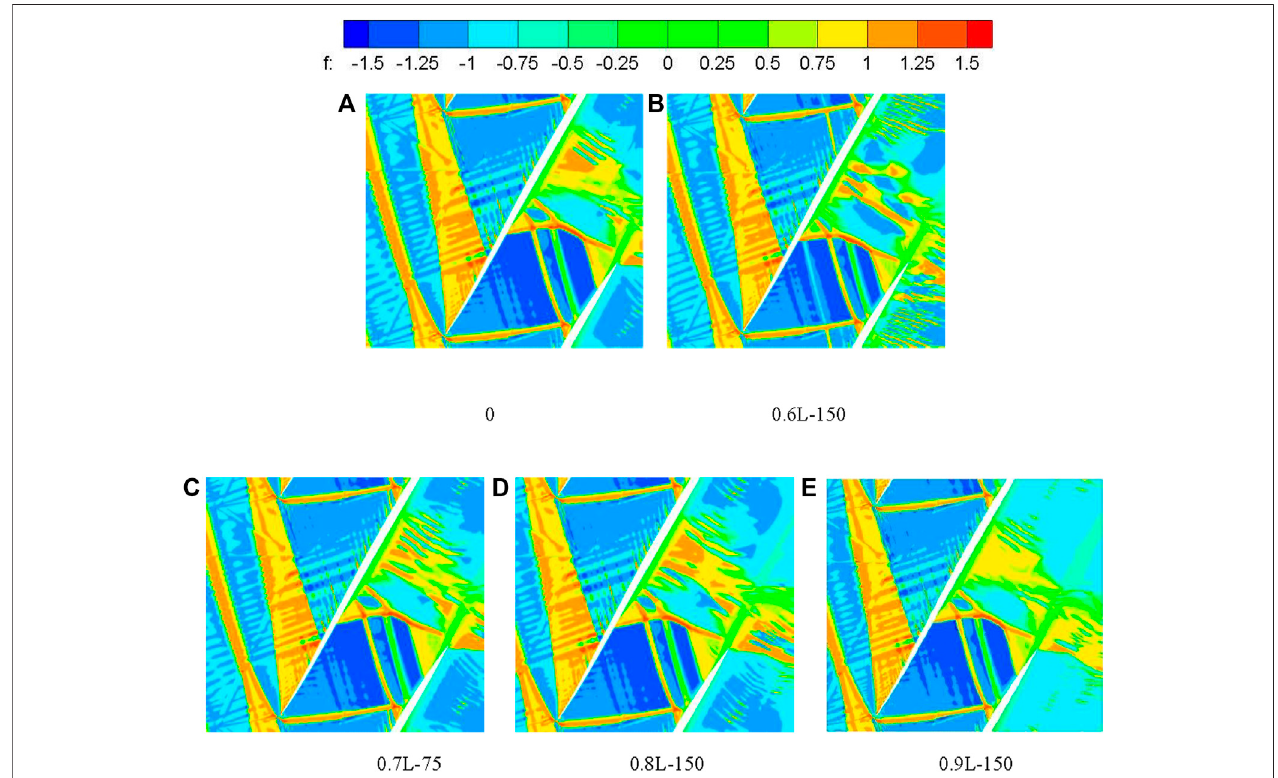
FIGURE 9 | Shock function contours of the supersonic cascade and Partially enlarged.